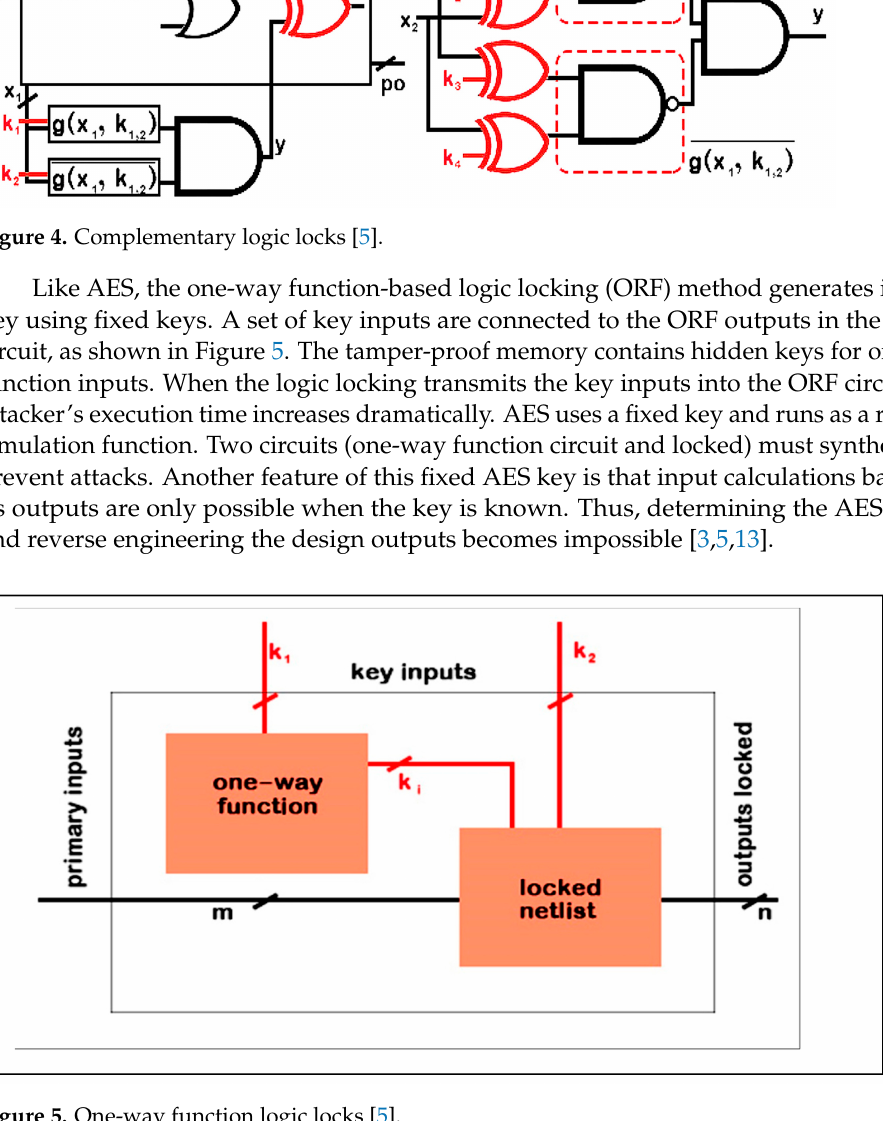
Figure 5. One-way function logic locks [5].